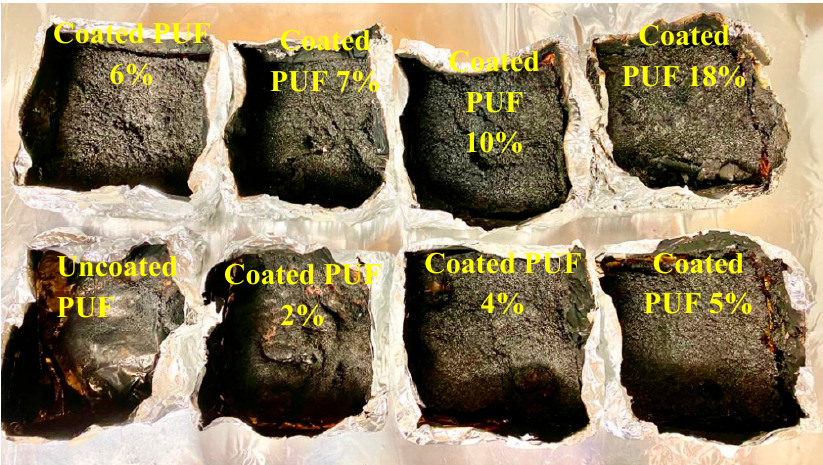
Figure 21. Optical photographs of uncoated and coated polyurethane foam with different uptake after cone calorimeter test.